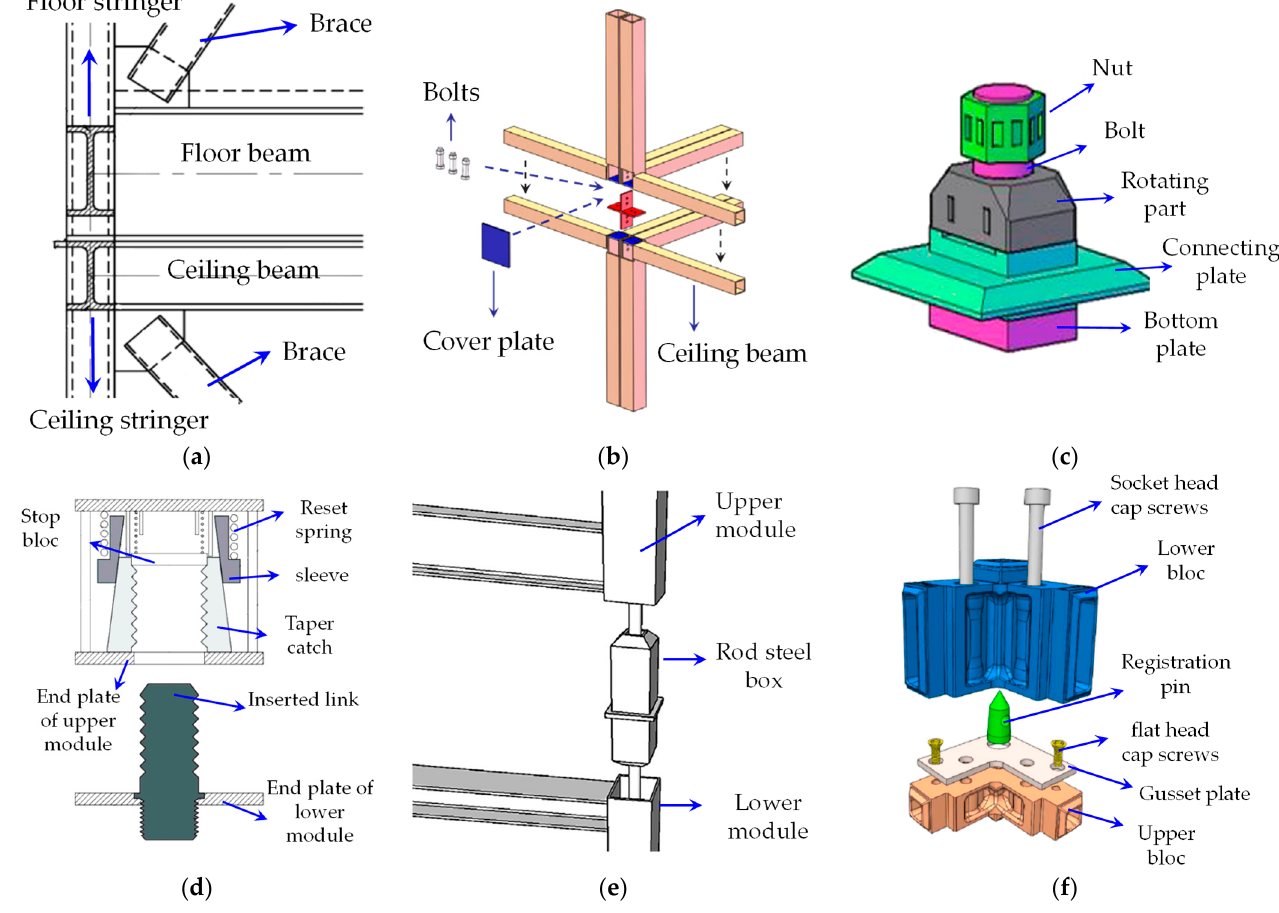
Figure 2. Representative inter-module connections for MSC: ( a ) welded connection [17]; ( b ) bolted connection [18]; ( c ) rotary connection [19]; ( d ) plug-in self-lock connection [20]; ( e ) vertical post- tensioned connection [21]; and ( f ) VectorBloc connection [22,23].